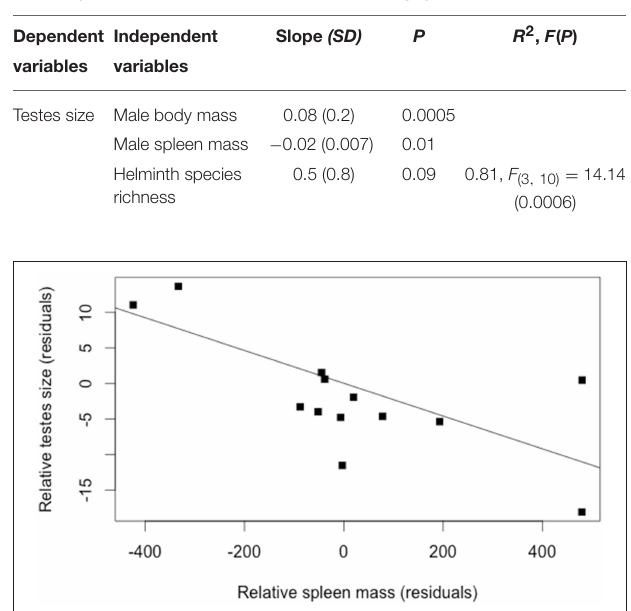
TABLE 4 | Best model explaining testes size in rodent species using independent contrasts (initial model with body mass, male spleen mass, helminth species richness, microparasite species richness, host abundance, host body mass, habitat centrality and centrality in sharing helminth parasites or centrality in sharing microparasites) using the AIC criteria (with SD = standard deviation of the slope).